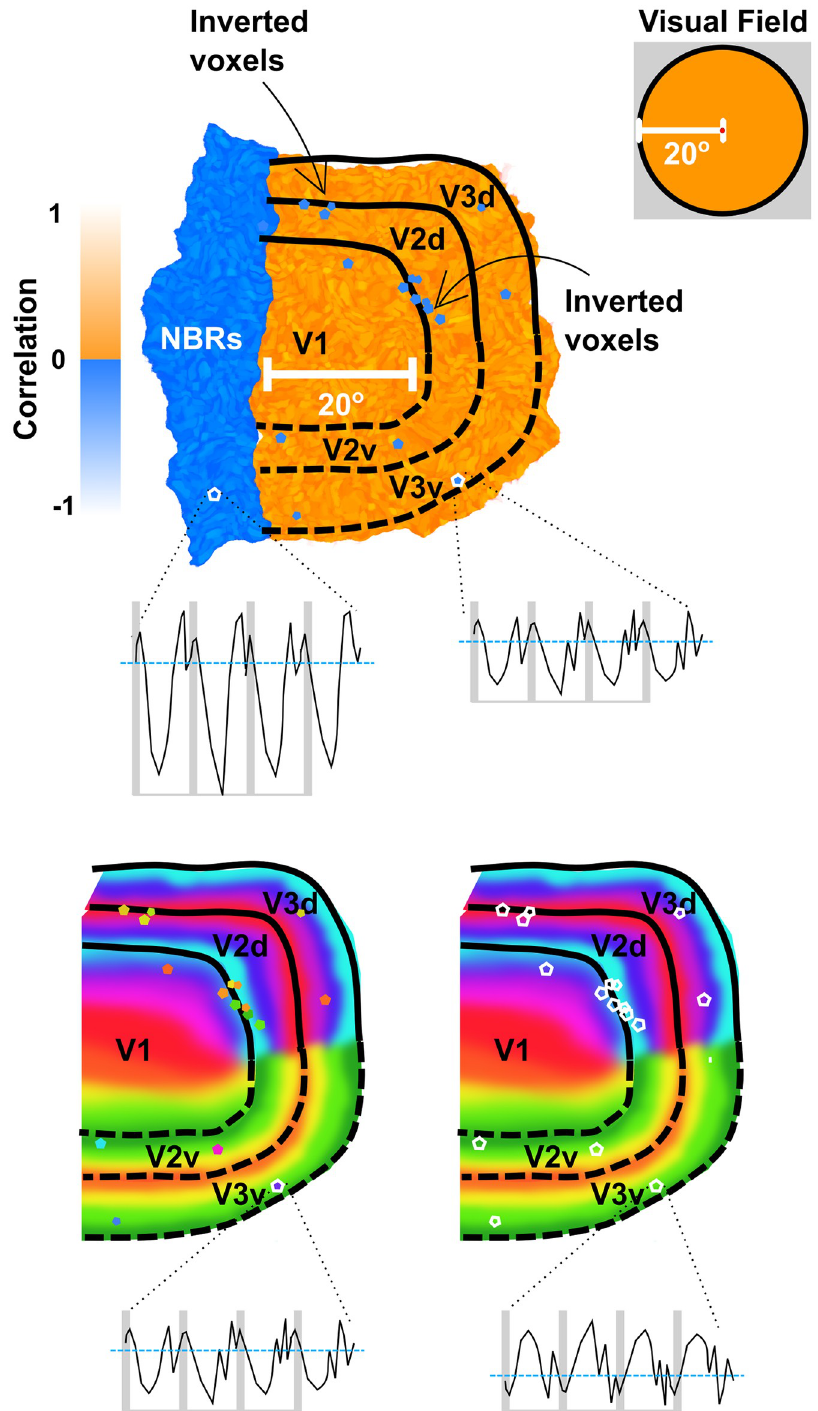
Fig 17. Negative BOLD responses vs. inverted voxels in visual cortex. NBRs form a large cluster immediately outside the eccentricity range of the stimulated region of the visual field. Inverted voxels are located within this range and are more isolated or form smaller clusters, often associated with venous artefact. NBRs have stronger and less noisy time courses. The correction of inverted voxels as shown in the bottom panel produces more coherent retinotopic maps, whereby the phase of corrected inverted voxels match those of their